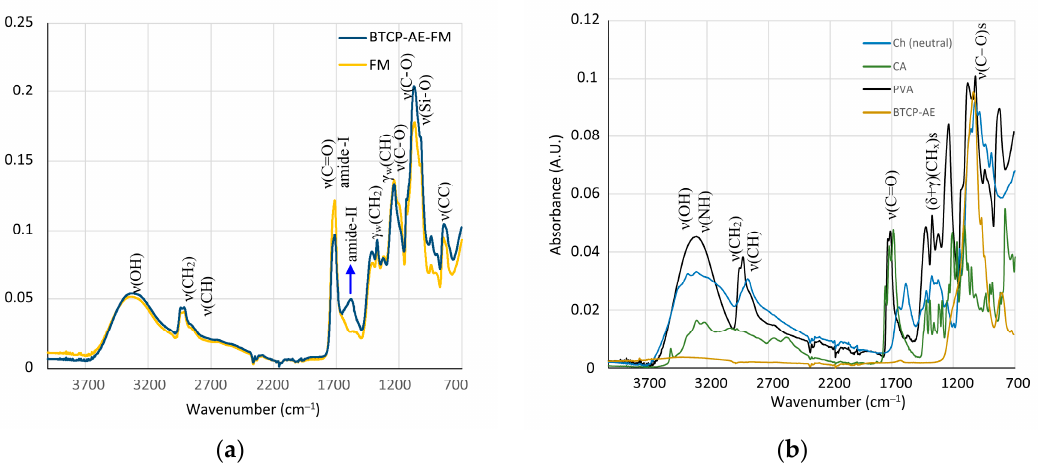
Figure 5. ( a ) IR spectra of the BTCP-AE-FM and FM fibrous meshes. The blue arrow indicates the pronounced presence of amide bonds in the aerogel composite mesh. ( b ) IR spectra of the starting materials showing highly overlapping peaks in the fi ngerprint region.